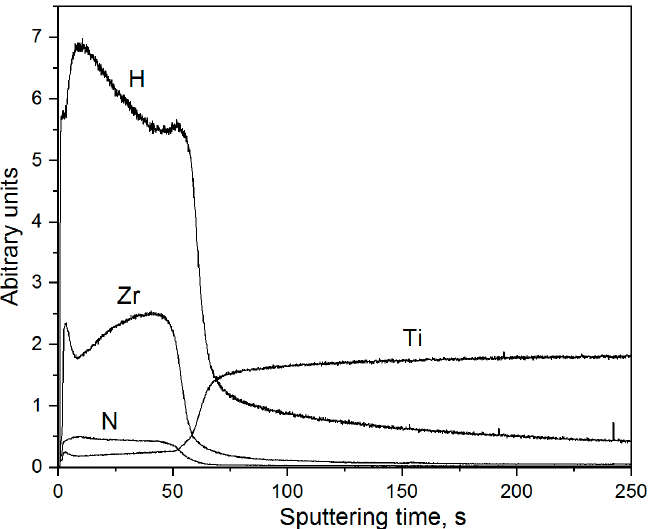
Figure 2. Distribution of Ti, Zr, nitrogen, and hydrogen atoms in the TZ1SMC specimens (coating formation time—90 min) after electrolytic hydrogenation in a physiological saline solution.